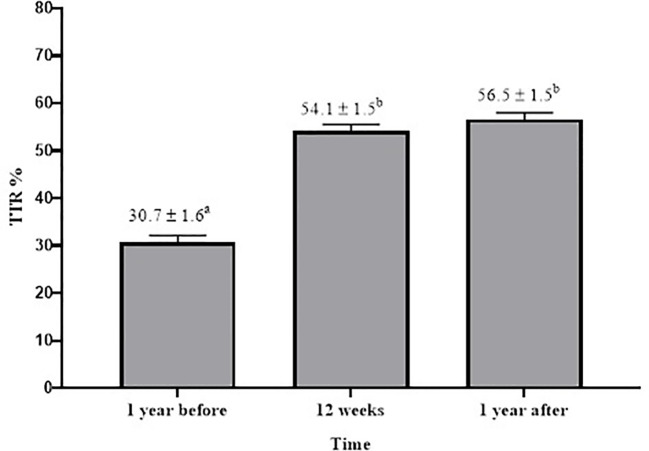
Comparison of Time in the Therapeutic Range (TTR) means in different periods (1 year before, after 12 weeks of pharmaceutical care and 1 year after). For this analysis, we used Friedman’s two-way analysis of variance by ranks, for comparing the 3 TTRs. Friedman post-hoc Dunn test was used for pairwise comparisons. Data are presented as mean % ± SE. Values with different superscript letters are significantly different (p < 0.001).